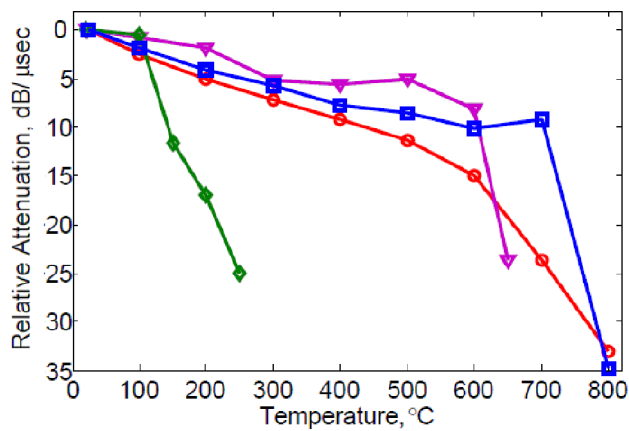
Figure 8. Surface acoustic wave attenuation of (0°, 138°, 27°) langasite SAW devices with different overlayers as a function of temperature. Measurements were performed at 335 MHz. Blue square  : non-layered langasite; purple triangle  : sputter-coated 200 nm ZnO/langasite; red round  : spin coated 200 nm SiO /langasite; green diamond  : spin 2 coated ZnO (140 nm)/SiO (200 nm)/langasite. 2